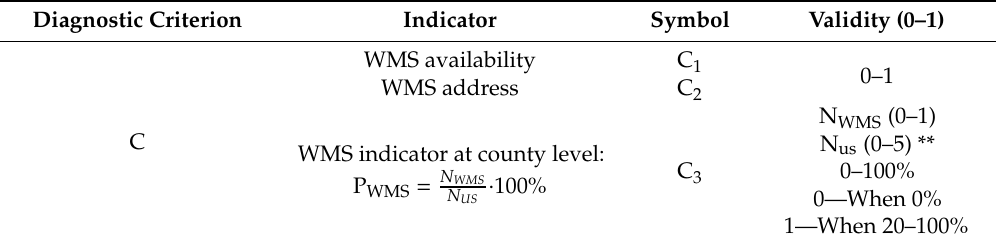
Table 4. WMS Network Service.